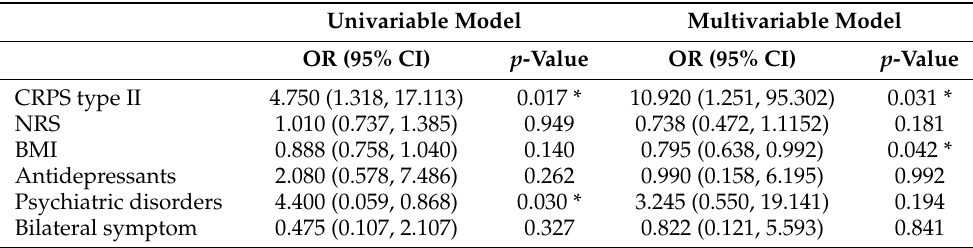
Table 3. Result of the univariable and multivariable logistic regression analysis of variable factors for abnormal